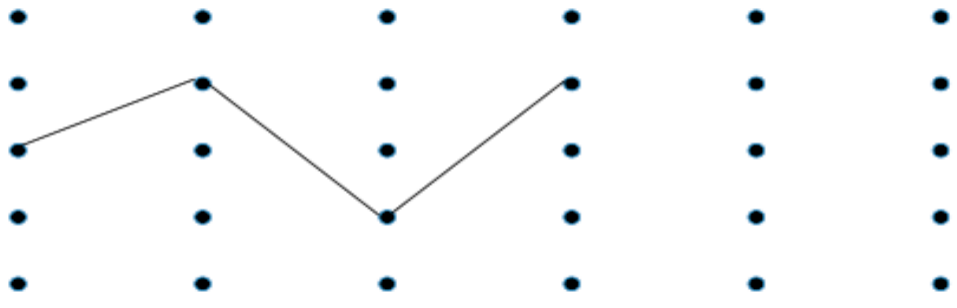
Figure 2. Combination of options of the considered projects of renewable energy sources (3rd option of the 1st project, 2nd option of the 2nd project).